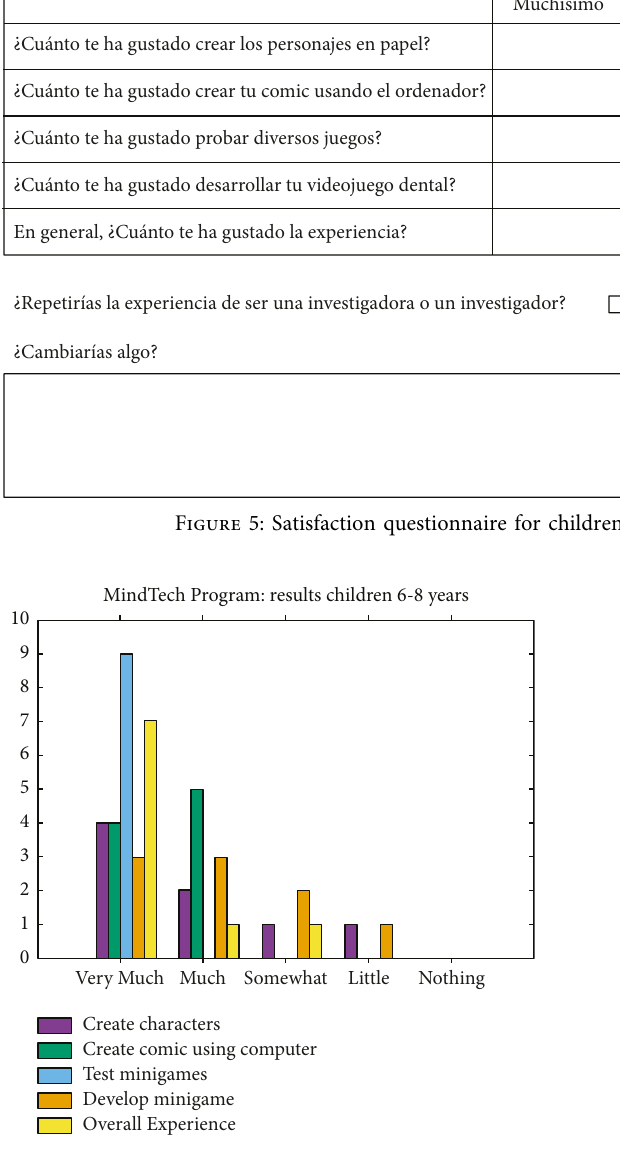
Figure 7: Results of the satisfaction survey for the first intervention with children aged 9–11 years of age (summer